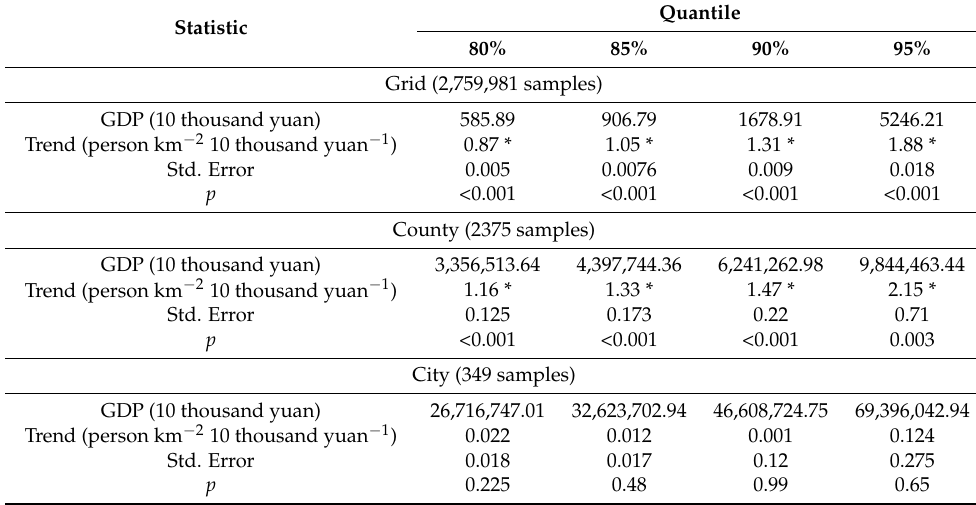
Table 2. Summary statistics results of upper-quantile ( ≥ 80th-percentile) GDP (including trends, standard errors, and p values) as a function of population exposure to PM 2.5 . Statistic